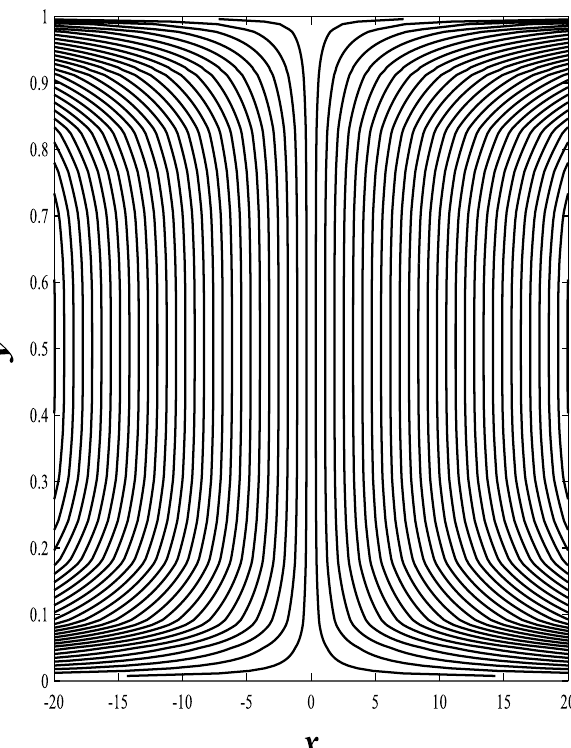
Figure 32. Stream lines profile at F = 0.8.